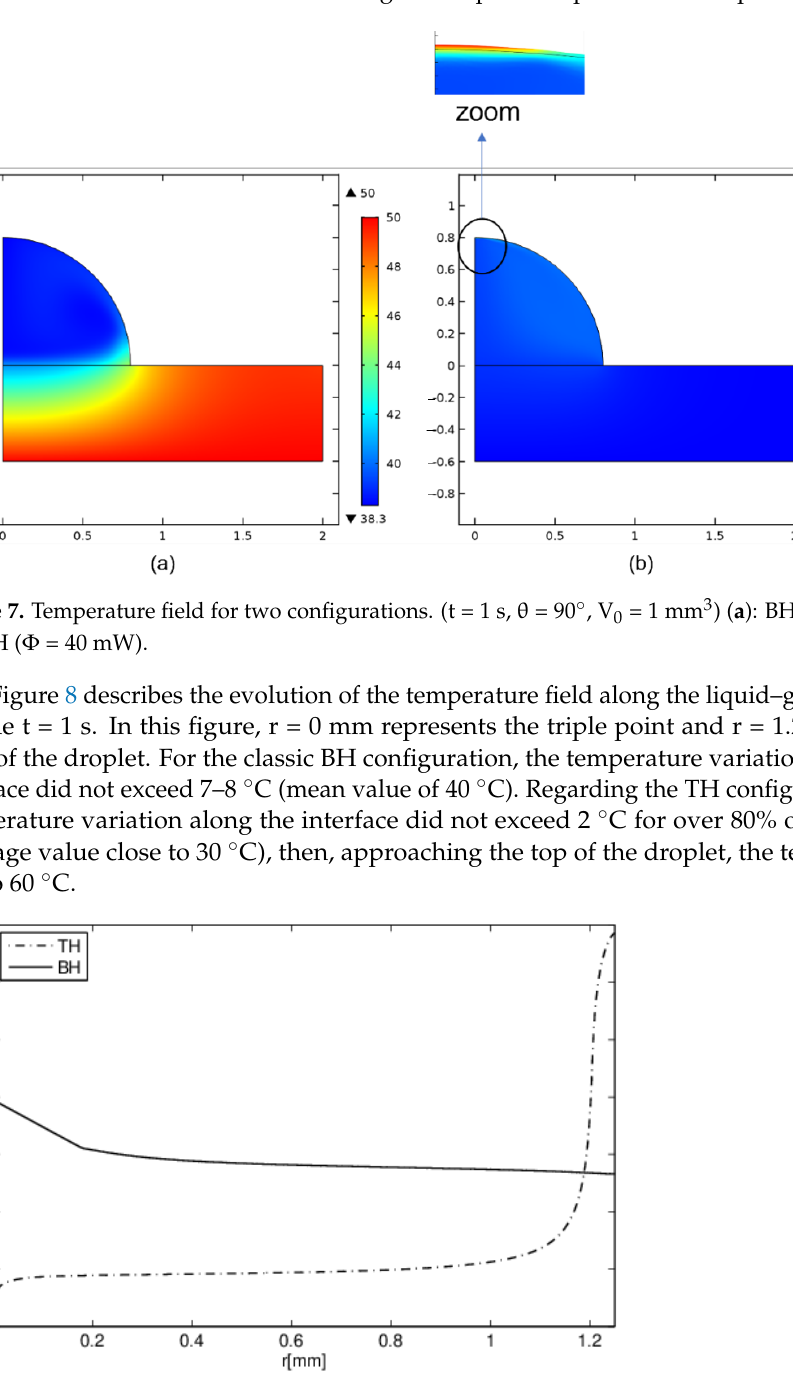
Figure 8. Temperature evolution along the interface for two configurations. (t = 1s,  = 90°, V 0 = 1 ◦ C, Φ = 40 mm 3 , T h = 50 °C, Φ = 40 mW). V 3 , T 0 = 1 mm h = 50